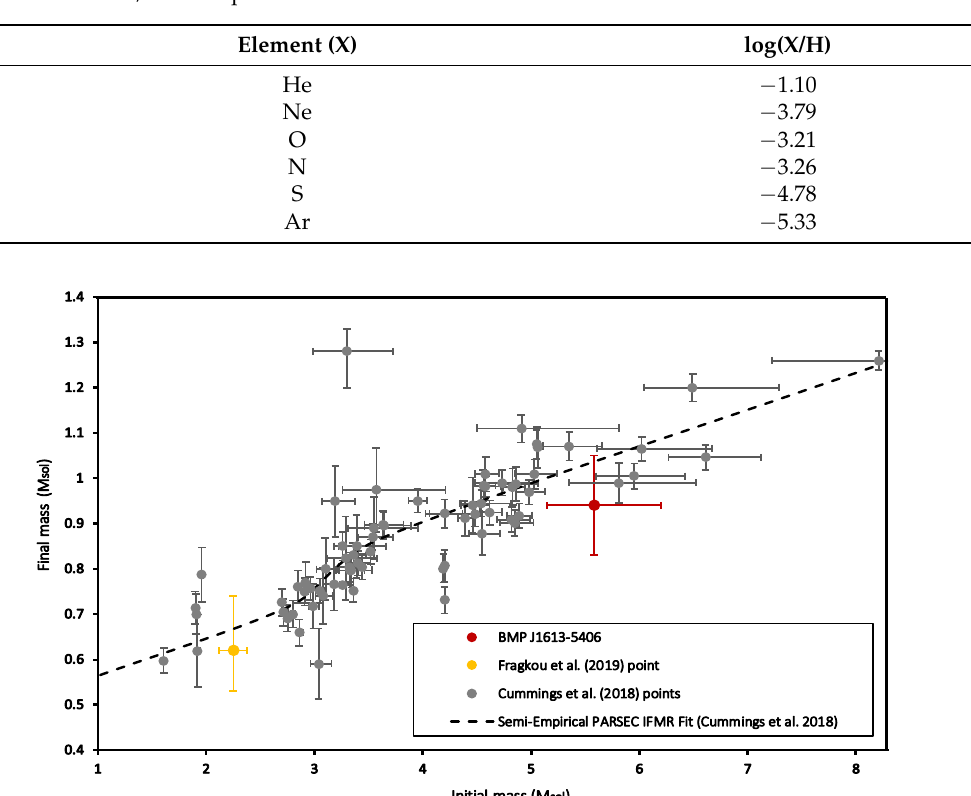
Figure 2. The IFMR [2] with our point in red. The yellow point refers to the only other instance of a